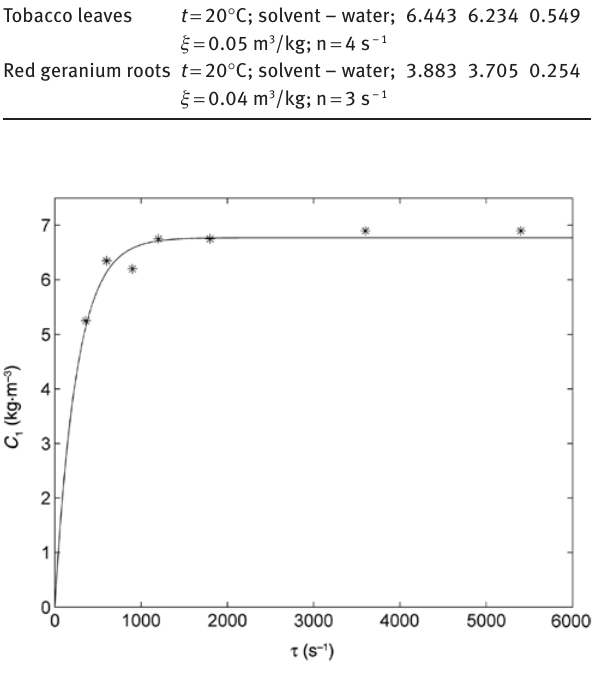
Figure 3: Dependence of concentration on time at t = 20 ° C; ζ = 0.05 m 3 /kg and solvent water for System